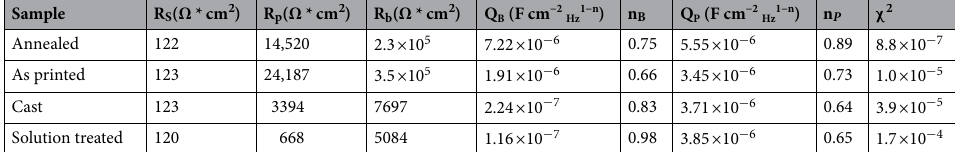
Table 4. Results of the fitting of the experimental data coming from EIS tests on the samples after 0 h of immersion.